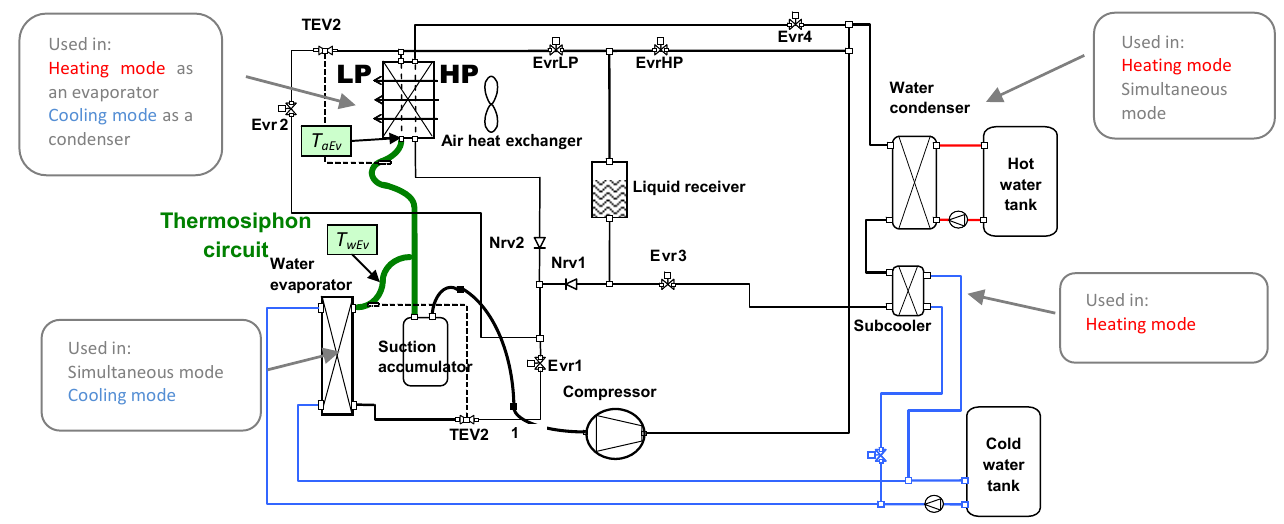
Figure 24. Schematic diagram of the first HPS prototype. Table 12. Annual simulation results obtained with TRNSYS.